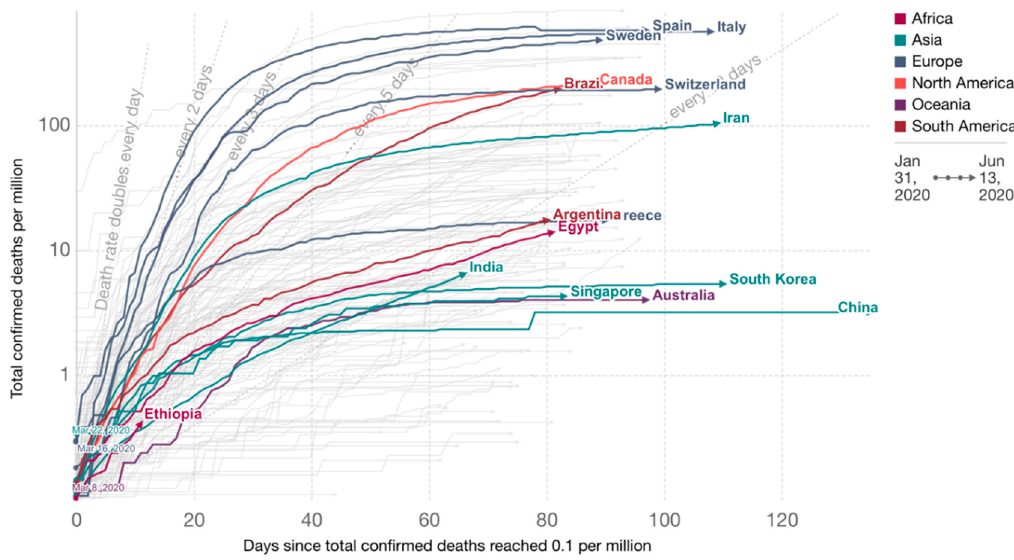
Figure 2. Intensity of government response strategies.